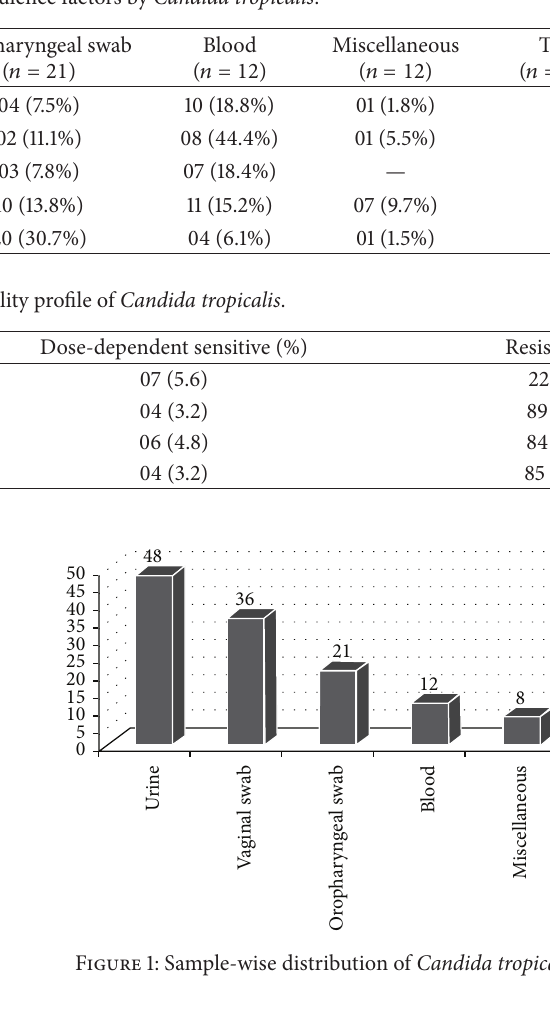
Table 1: Production of various virulence factors by Candida tropicalis .